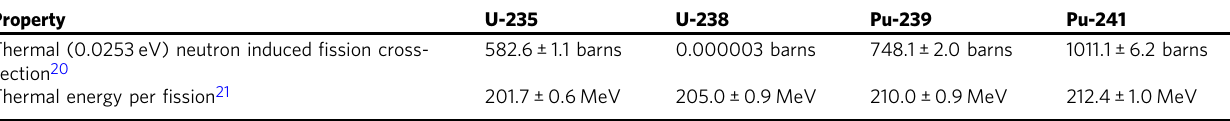
Table 1 Properties of key reactor isotopes